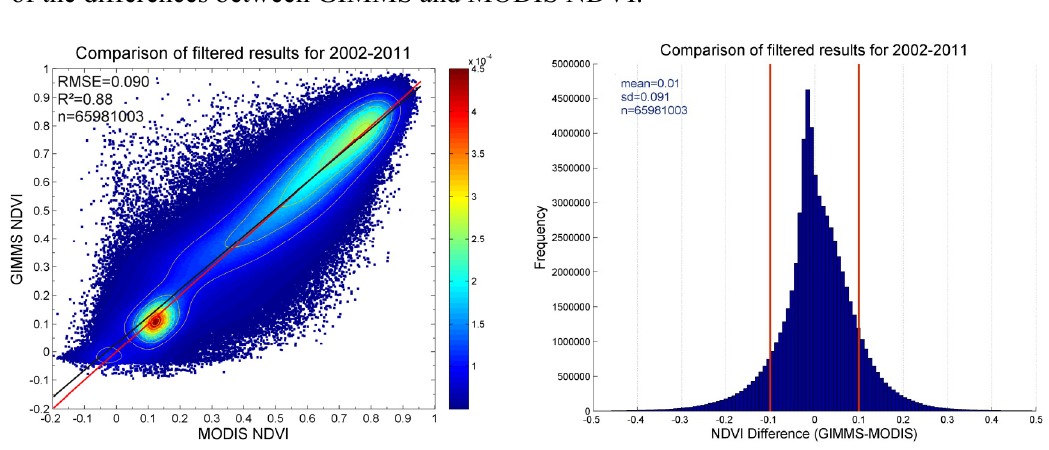
Figure 6. Co-distribution of NDVI values from GIMMS and MODIS derived from the full image extent and weekly observations across all weeks between 2002 and 2011. ( left ) scatterplot with 1-to-1 line (red) and regression line (black); ( right ) frequency distribution of the differences between GIMMS and MODIS NDVI.